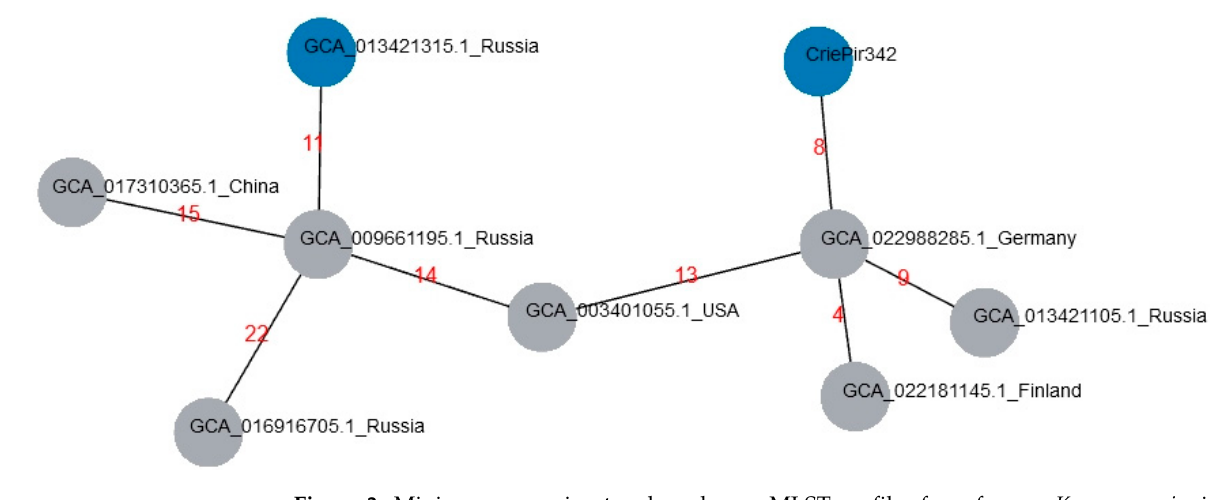
Figure 3. Minimum spanning tree based on cgMLST profiles for reference K. pneumoniae isolates and CriePir342. Since all our isolates possessed the close profiles, only CriePir342 is indicated. Red numbers show the number of allele differences between the corresponding isolates. The isolates carrying IncQ1 plasmid are colored in blue. Table 3. Reference isolates from Genbank, with closest matches to the isolates studied according to cgMLST analysis.